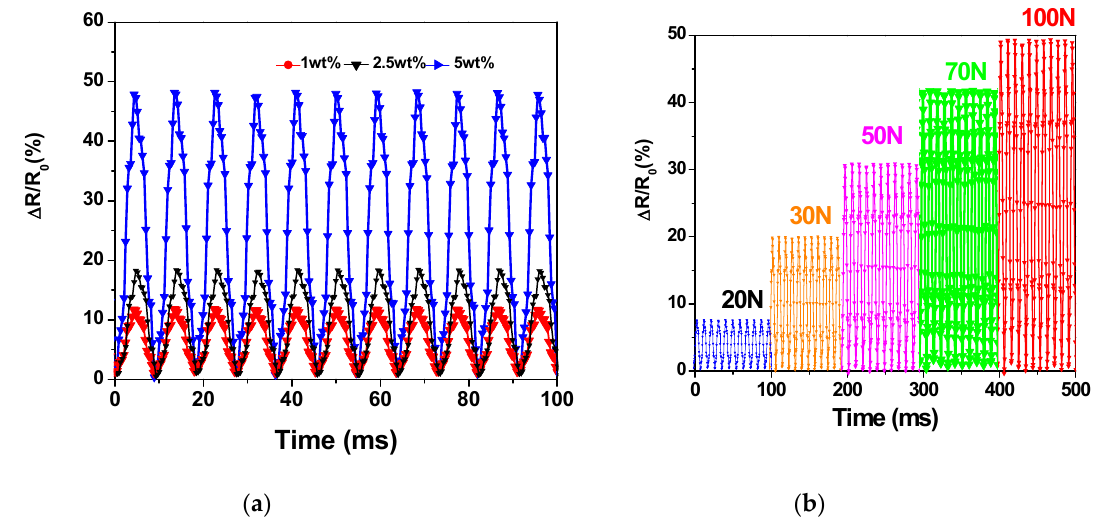
Figure 4. Pressure-induced resistivity changes for samples with various compositions of mats under a constant applied force (100 N) ( a ), and the pressure-induced resistivity changes at different forces (5 wt.% Ti 3 C 2 T x ) ( b ).